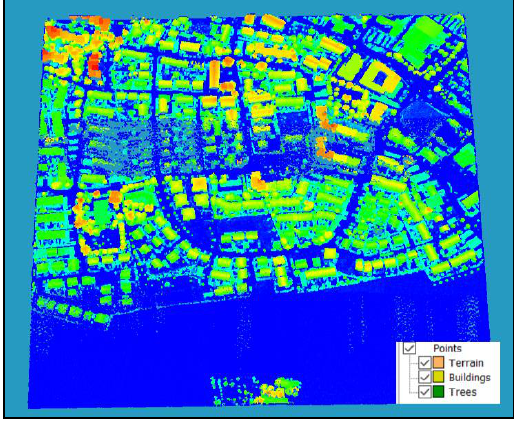
Figure 2. Classified LiDAR point cloud